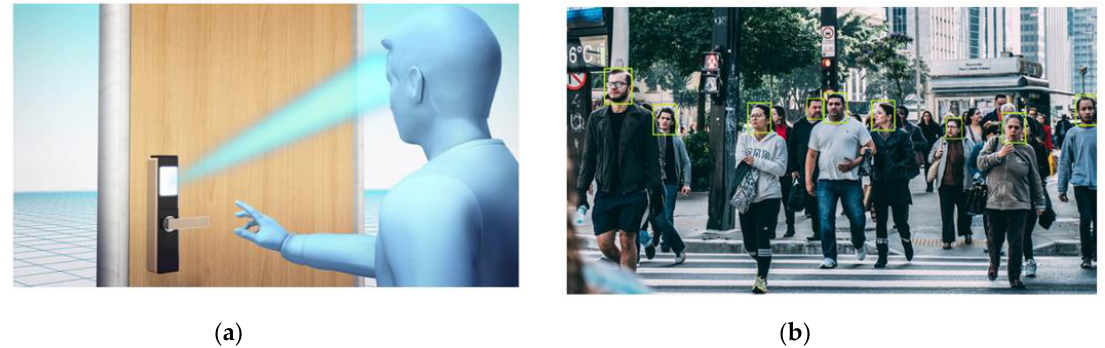
Figure 47. Examples of IoT (internet of things) using face recognition: ( a ) door unlock and ( b ) smart